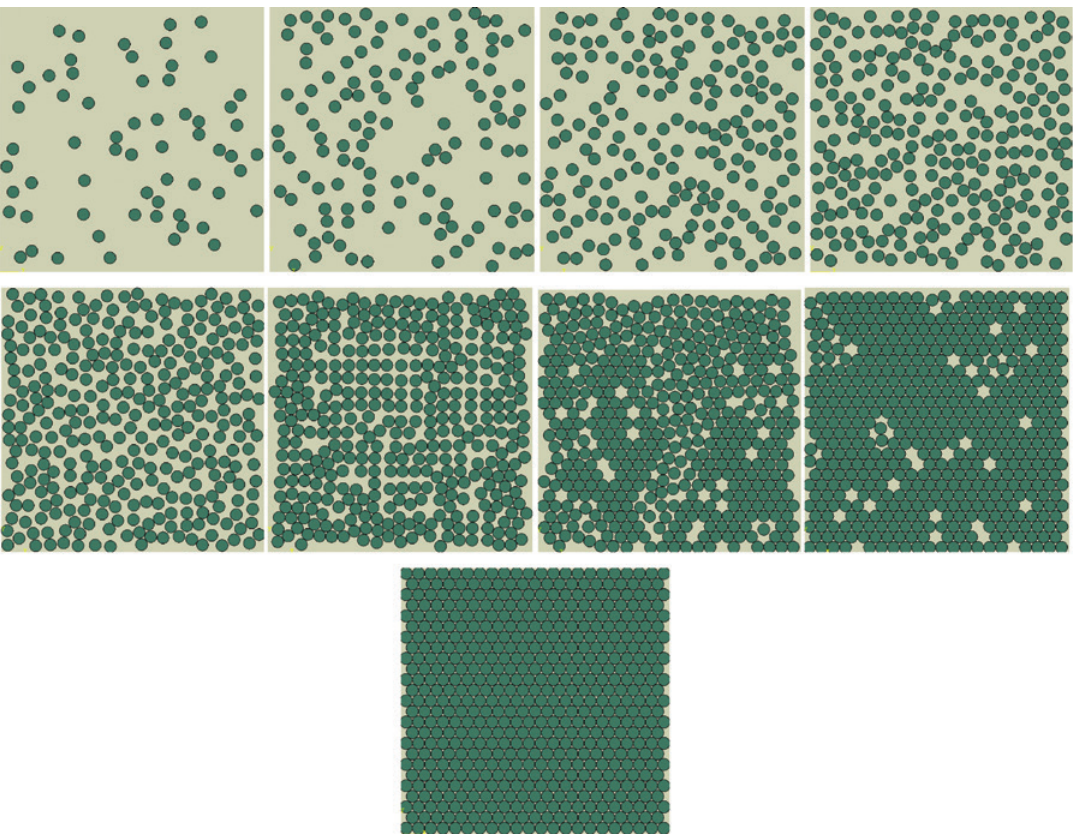
Figure 6: Images of different volume fractions 0.1, 0.2, 0.3, 0.4, 0.5, 0.60, 0.7, 0.8 and 0.9072 (bee honeycomb).